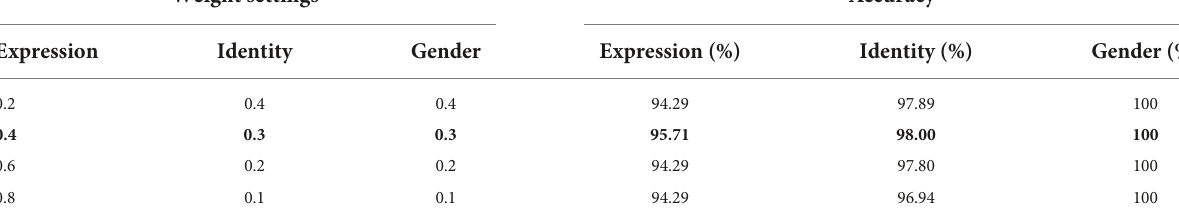
TABLE 1 Face classification performance of multi-task deep learning network (MTDLN) at varied task weights. Weight settings